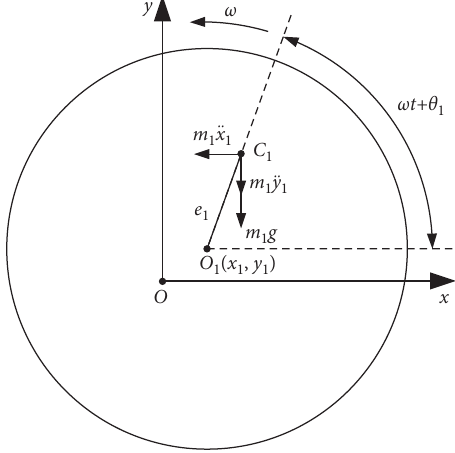
Figure 3: Stress analysis diagram of disk. Table 1: Parameters of rod fastening rotor system.